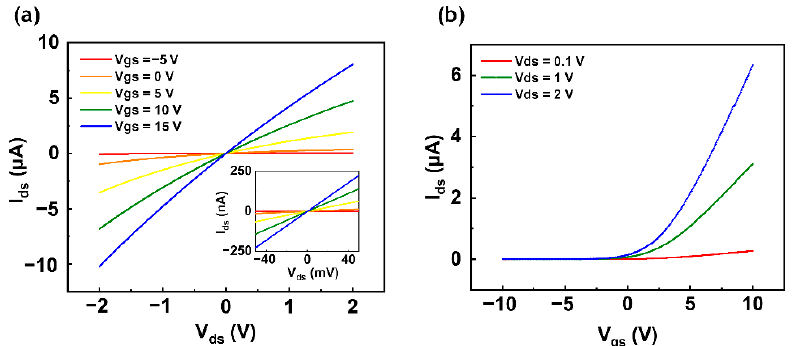
Figure 2. Output and transfer curves of the memory device. ( a ) Output curve (I ds –V ds ) with gate voltage from − 5 V to 15 V with 5 V step. Inset shows an ohmic contact of the device. ( b ) Transfer curve (I ds –V gs ) measured at drain voltages of 0.1 V, 1 V, and 2 V with the top-gate voltage sweep from − 10 V to +10 V.